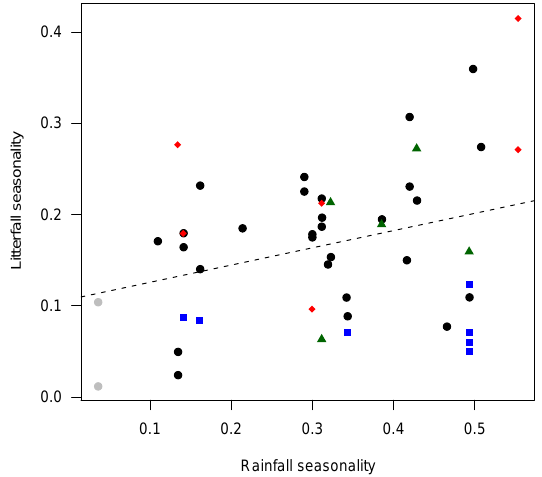
Fig. 8. Litterfall seasonality index SL versus rainfall seasonality index SR. The dashed line represents a regression across all points ( r 2 = 0 . 10, p = 0 . 02). Color codes show forest types as in Fig.